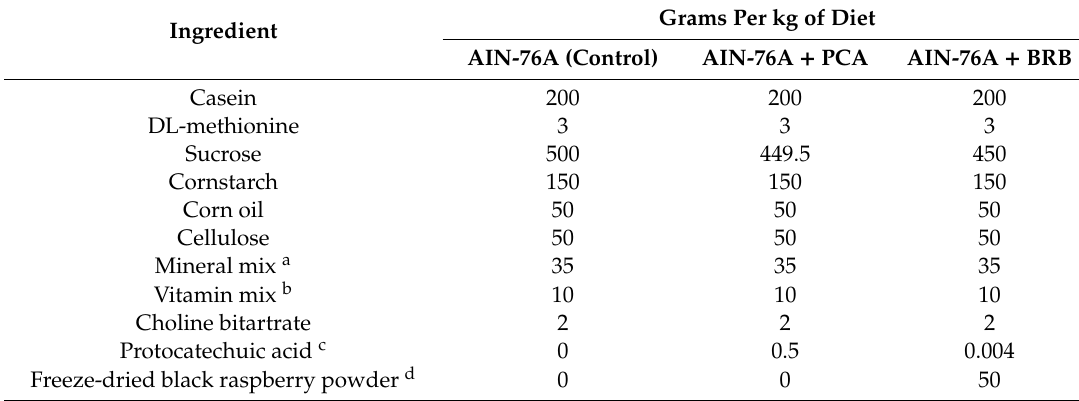
Table 1. Composition of control, protocatechuic acid (PCA) and black raspberry (BRB) powder, containing pelleted murine